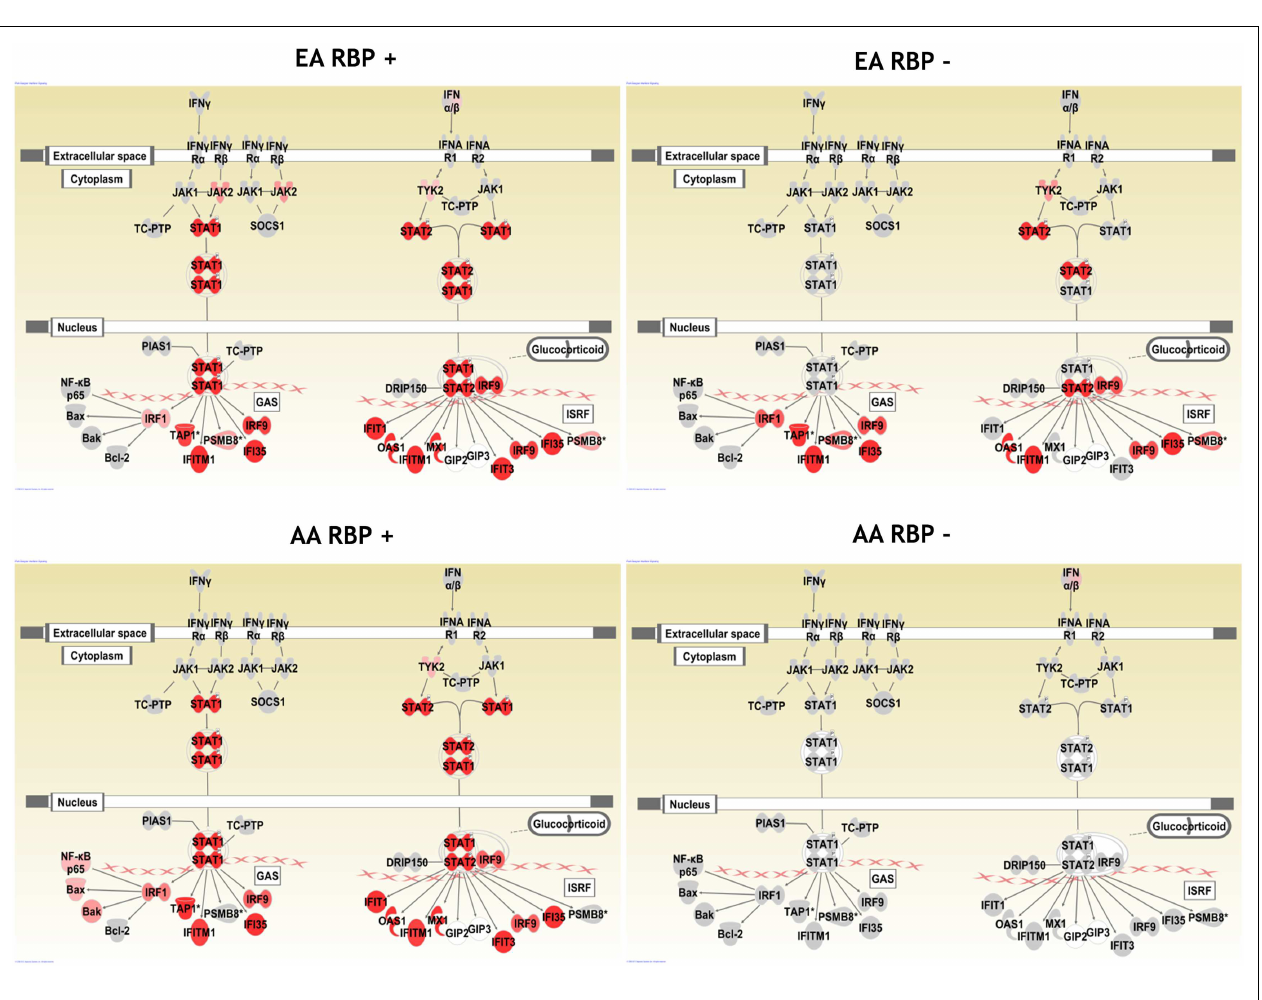
ancestral background. AA, African-American; EA, European-American; RBP + , anti-RNA-binding-protein (RBP) antibody positive; and RBP − , RBP antibody negative. Pictures generated using Ingenuity Pathway Analysis